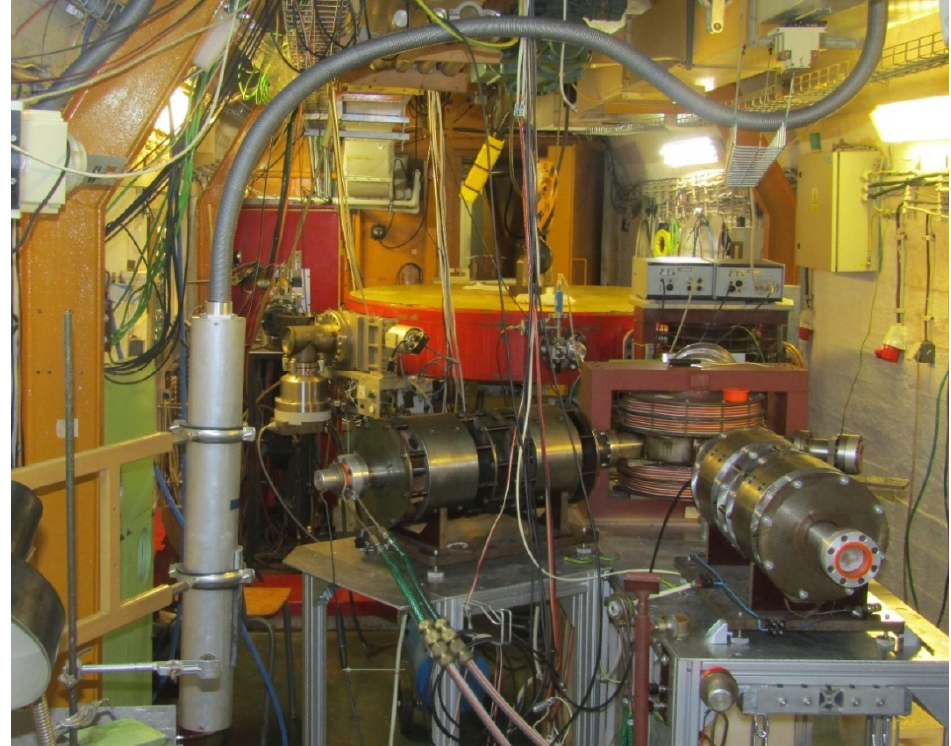
Figure 1. Microtron MT-25 with two electron beam outlets; the left one has the tungsten, water-cooled converter installed, and the irradiation terminal for short-time irradiations in the working position, connected to the main transporting tube of the pneumatic tube delivery system.